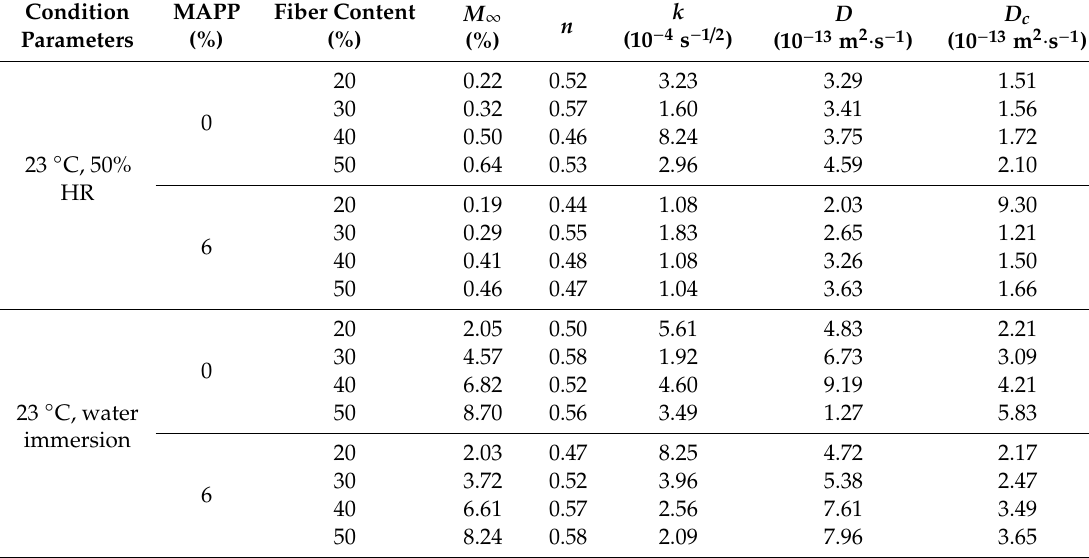
Table 1. Parameters of Fick’s Law and moisture di ff usion coe ffi cient of PP composites reinforced with ONPF. MAPP: maleated with maleic anhydride.